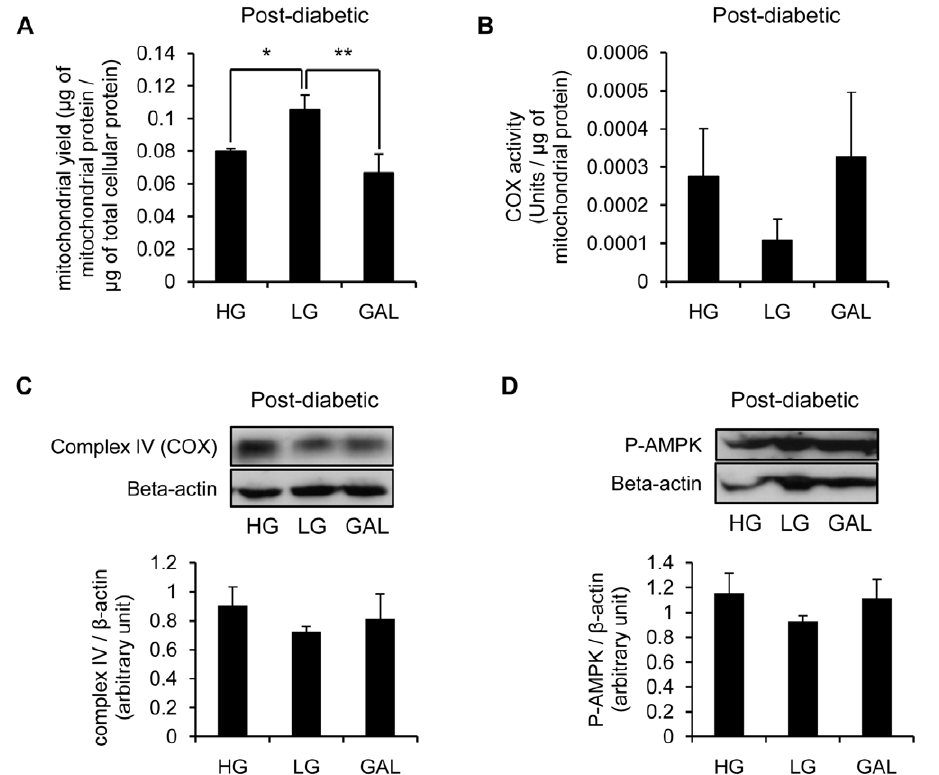
Figure 6. Absence of an increase in cytochrome C oxidase activity and AMPK phosphorylation in post-diabetic myotubes differentiated in galactose media. A. Mitochondrial yield measured in post-diabetic myotubes differentiated for 7 days in HG (25 mM glucose), LG (5 mM glucose) or GAL (10 mM galactose). Mitochondrial yield was determined as mitochondrial protein content per total cellular protein content. Results are presented as means 6 SEM, n=4. *, p , 0.05, LG vs HG, **, p , 0.01 LG vs GAL. B. Cytochrome C oxidase activity measured in isolated mitochondria from post-diabetic myotubes differentiated for 7 days in HG (25 mM glucose), LG (5 mM glucose) or GAL (10 mM galactose). Results are presented as means 6 SEM, n=4. *, p , 0.05, GAL vs HG and LG. C. Top panel: representative Western blot of Complex IV expression in post-diabetic myotubes differentiated for 7 days in HG (25 mM glucose), LG (5 mM glucose) or GAL (10 mM galactose). Beta-actin was used as a loading control. Bottom panel: quantification by densitometry of complex IV expression. Data are presented normalized to beta-actin expression. Data are shown as mean 6 SEM, n=4. D. Left panel: representative Western blot of P-AMPK expression in post-diabetic myotubes differentiated for 7 days in HG (25 mM glucose), LG (5 mM glucose) or GAL (10 mM galactose). Beta-actin was used as loading controls. Right panels: quantification by densitometry of P-AMPK. Data are presented normalized to beta-actin and AMPK a 2 expression. Data are shown as mean 6 SEM, n=4.